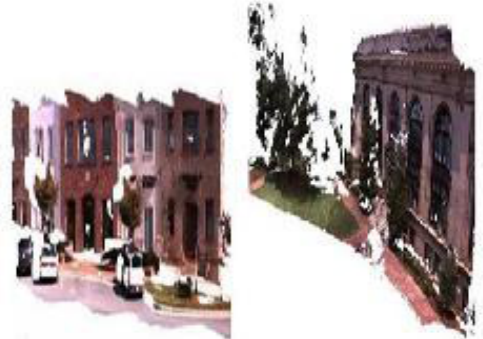
Fig.10- Reconstructed models from video frames in a Line for